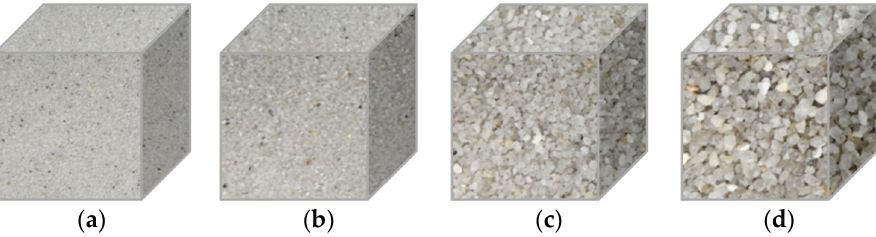
Figure 4. Brazilian standard sand: ( a ) #0.15 mm; ( b ) #0.30 mm; ( c ) #0.60 mm; and ( d ) #1.20 mm.